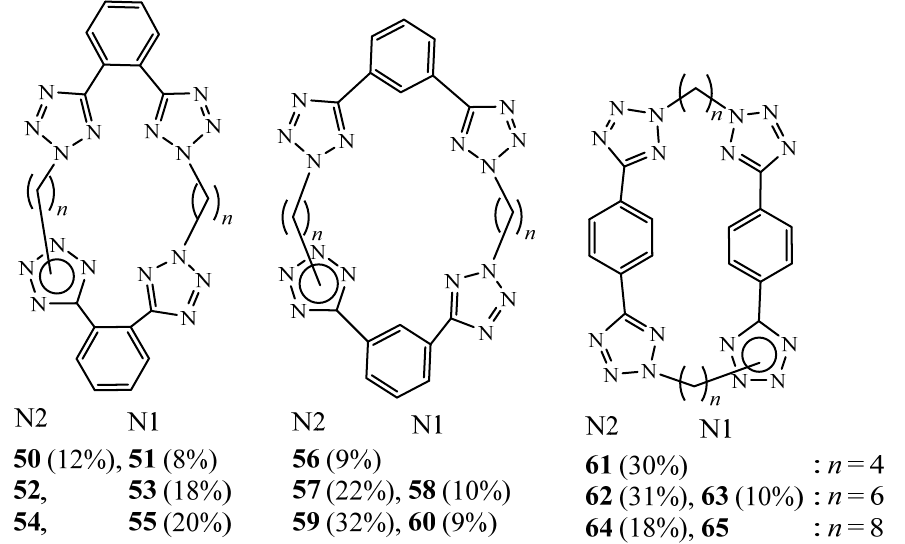
Figure 17. Structures of tetra-tetrazolic macrocycles 50 − 65. (Reprinted with permission from ref. [32]. Copyright 2007 Elsevier).